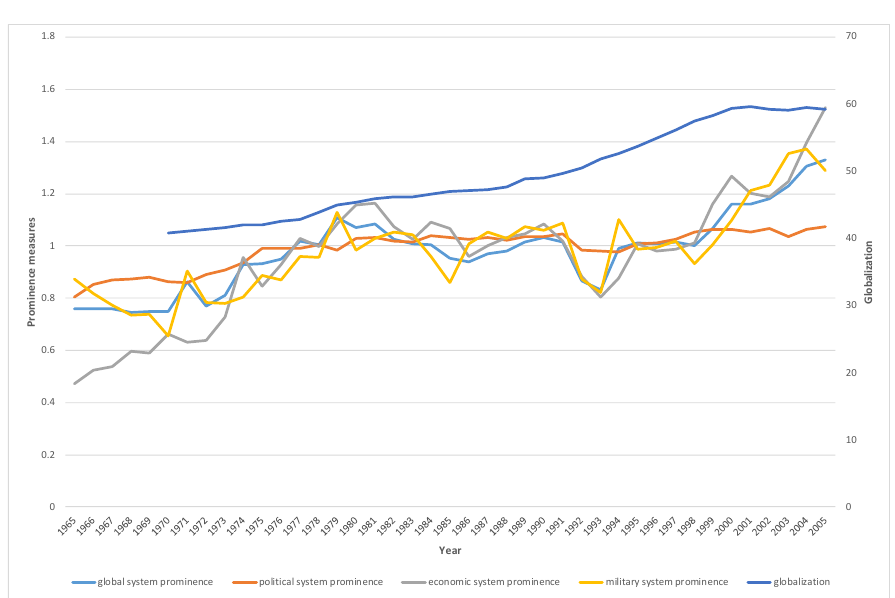
Figure 3: Evolution of Standard Deviation of Prominence Scores (1965 - 2005) and